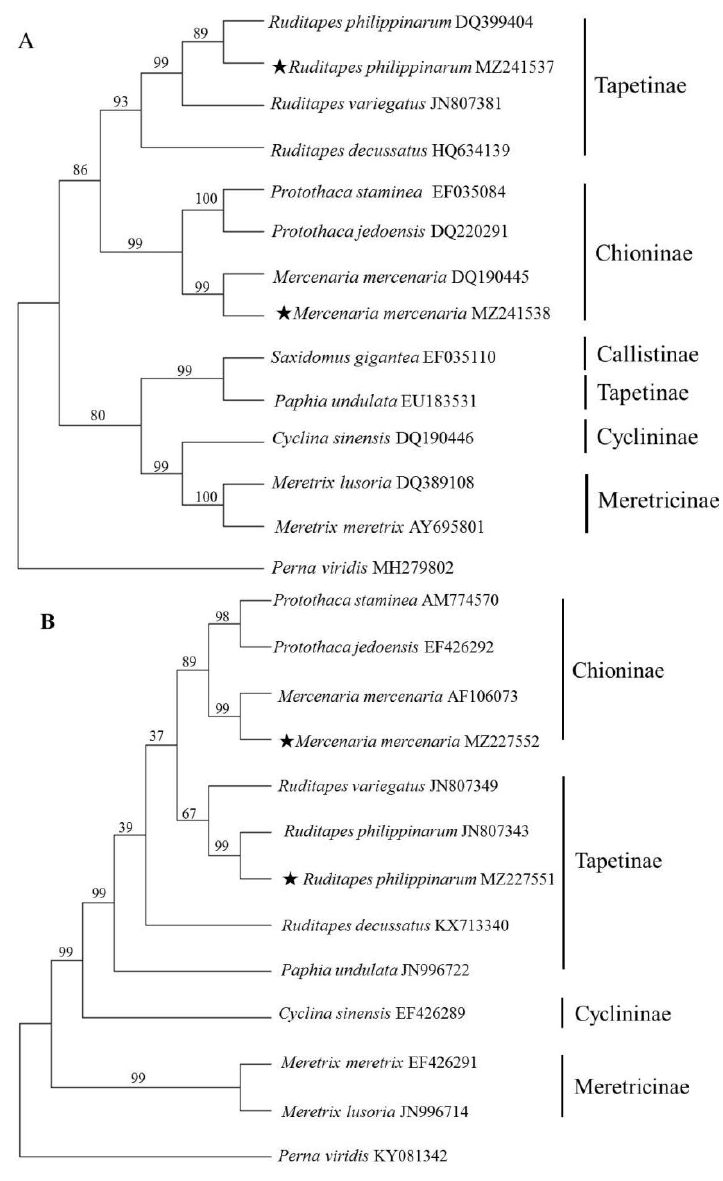
Figure 2. Phylogenetic trees constructed using the maximum likelihood (ML) method based on ITS ( A ) and 18S rRNA sequences ( B ) of Veneridae species. The asterisk ( (cid:70) ) means the sample collected ( A ) and 18S rRNA sequences ( B ) of Veneridae species. The asterisk ( ★ ) means the sample collected in the present in the present study.